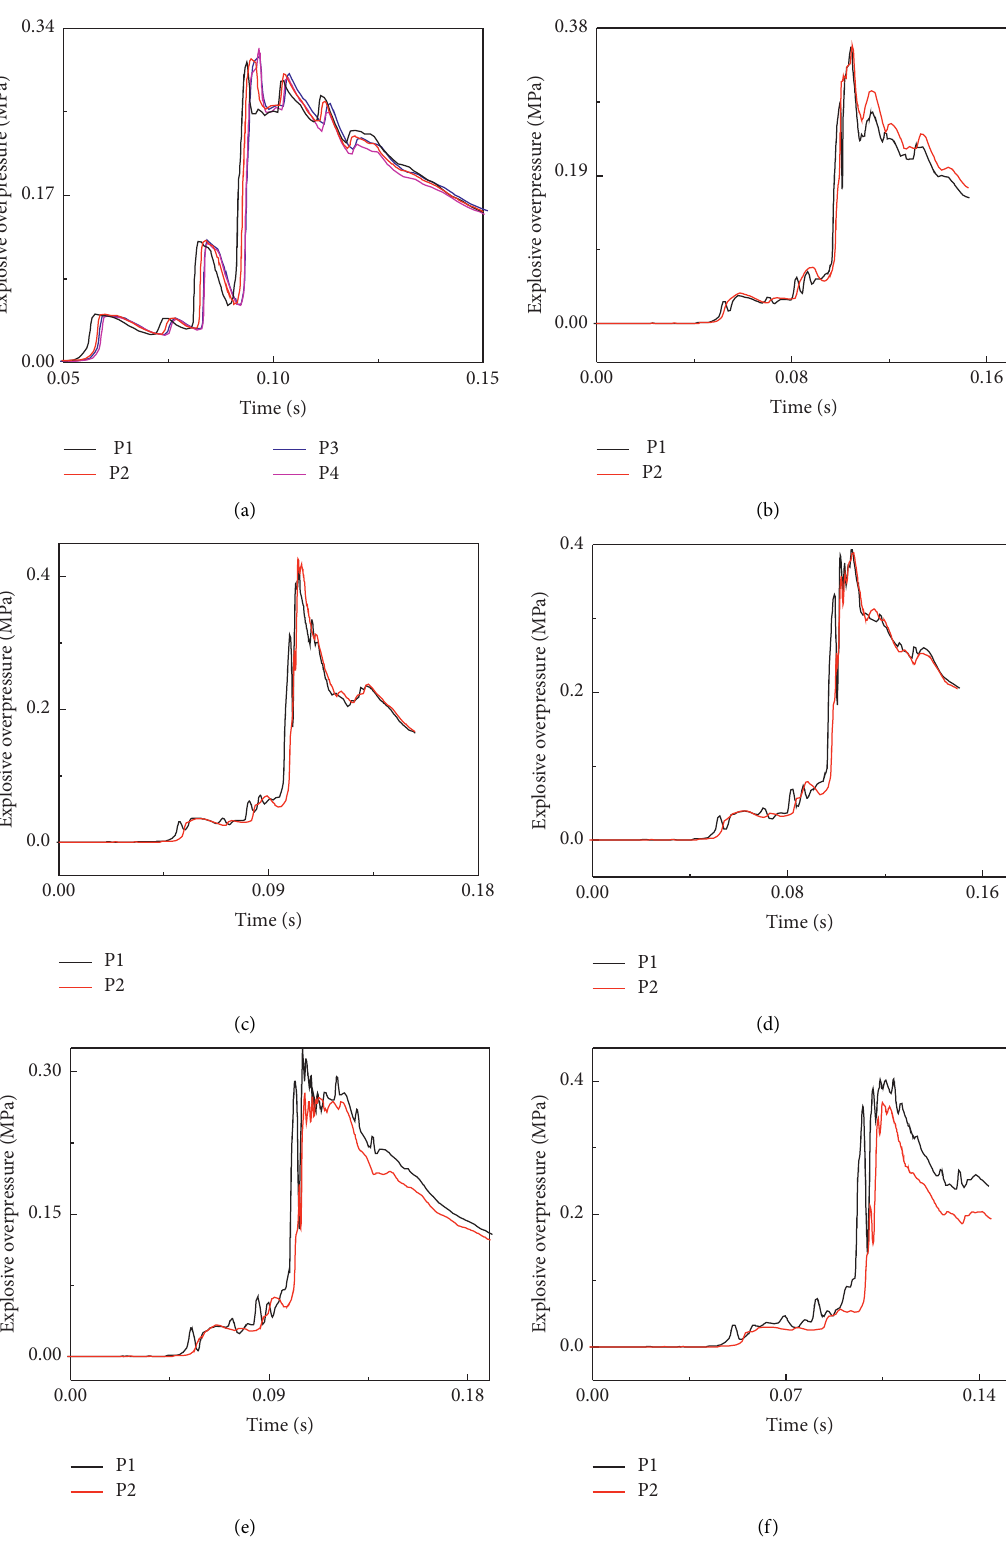
Figure 6: Explosion overpressure-time curve at the chamber inlet and outlet. (a) Pipeline section without a chamber; (b) chamber of L0.3m × W0.5m × H0.2m; (c) chamber of L0.5 m × W0.3 m × H0.2m; (d) chamber of L0.5m × W0.5 m × H0.2m; (e) chamber of L0.5m × W0.8m × H0.2m; (f) chamber of L0.8m × W0.5 m ×